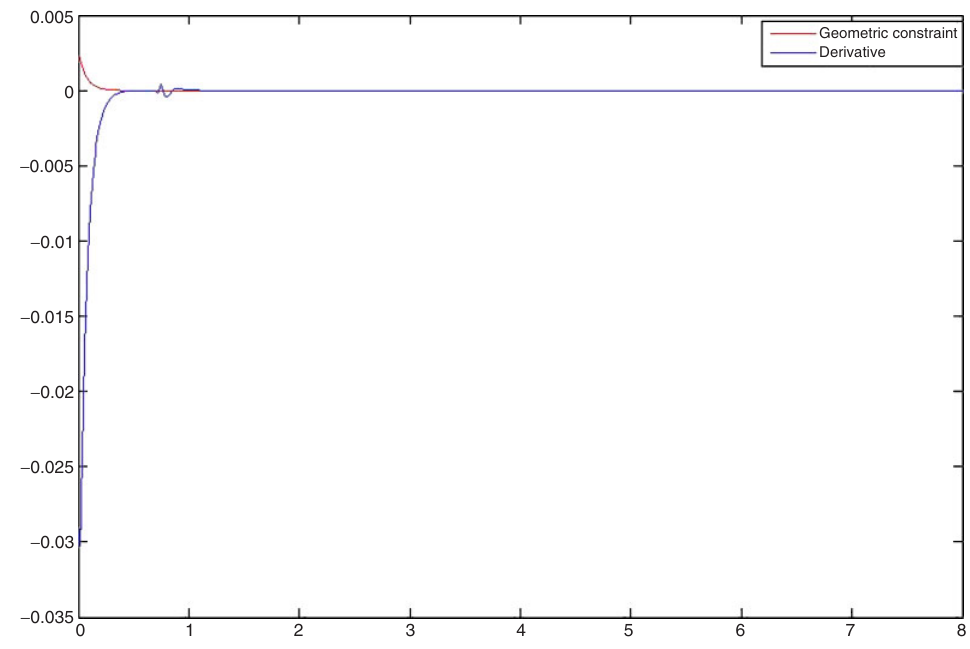
Figure 3 Geometric constraint and its